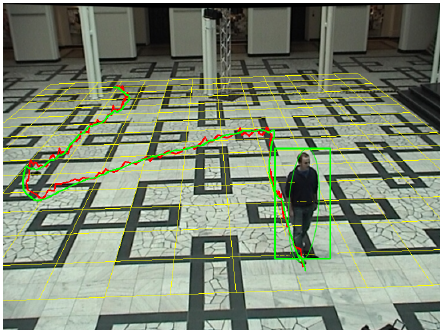
Figure 3: Workflow Detection and Tracking